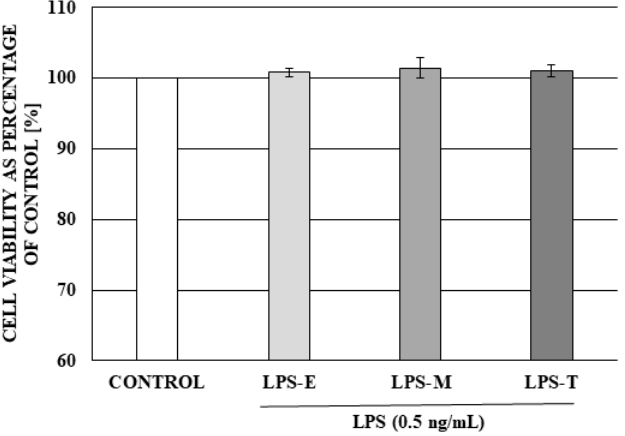
Figure 6. The effect of a low dose (0.5 ng/mL) of LPS from different serotypes of Salmonella spp: LPS from Salmonella Enteritidis (LPS-E), LPS from Salmonella Minnesota (LPS-M), LPS from Salmonella Typhimurium (LPS-T) on DRG cell viability. Cell viability was assessed using the MTT method. Data are presented as means of the percentage of the untreated control cells ± SE ( n = 4). Representative examples of dorsal root ganglia (DRG) neurons supplying the ileocecal valve observed during the present study in the cell culture are visualised in Figures 7 and 8.